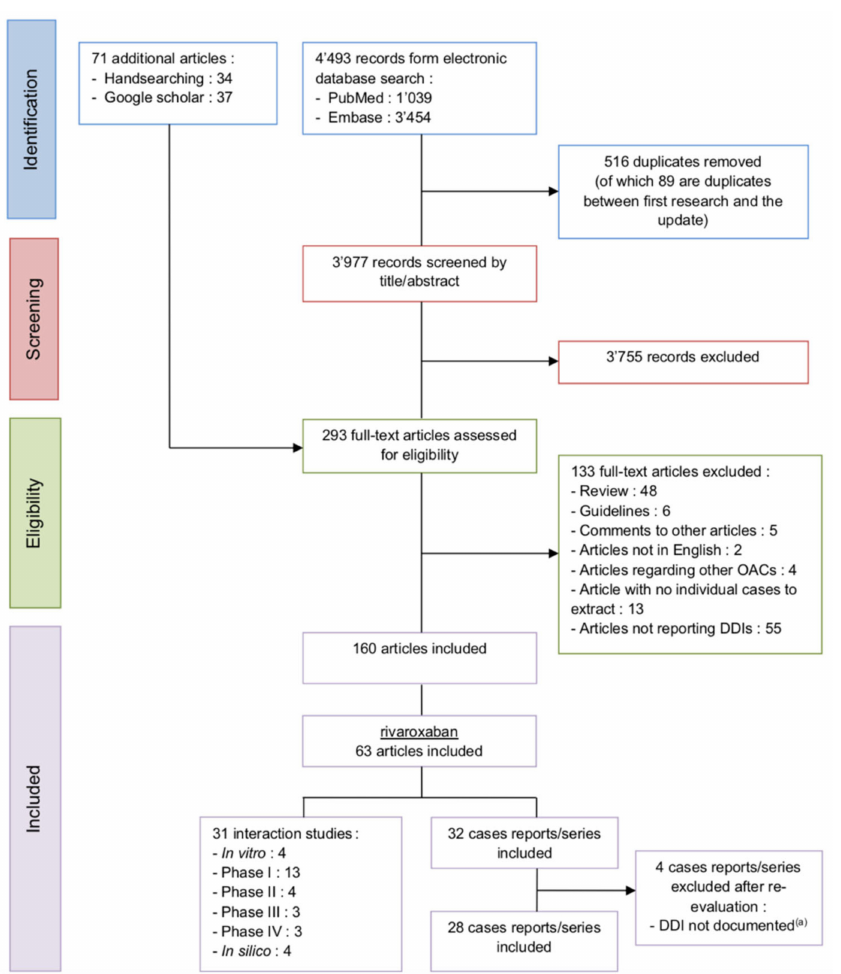
Figure 1. PRISMA flowchart of the rivaroxaban studies selection process DDI (drug-drug interaction) and OAC (oral anticoagulant), (a) or not understood from a pharmacological point of